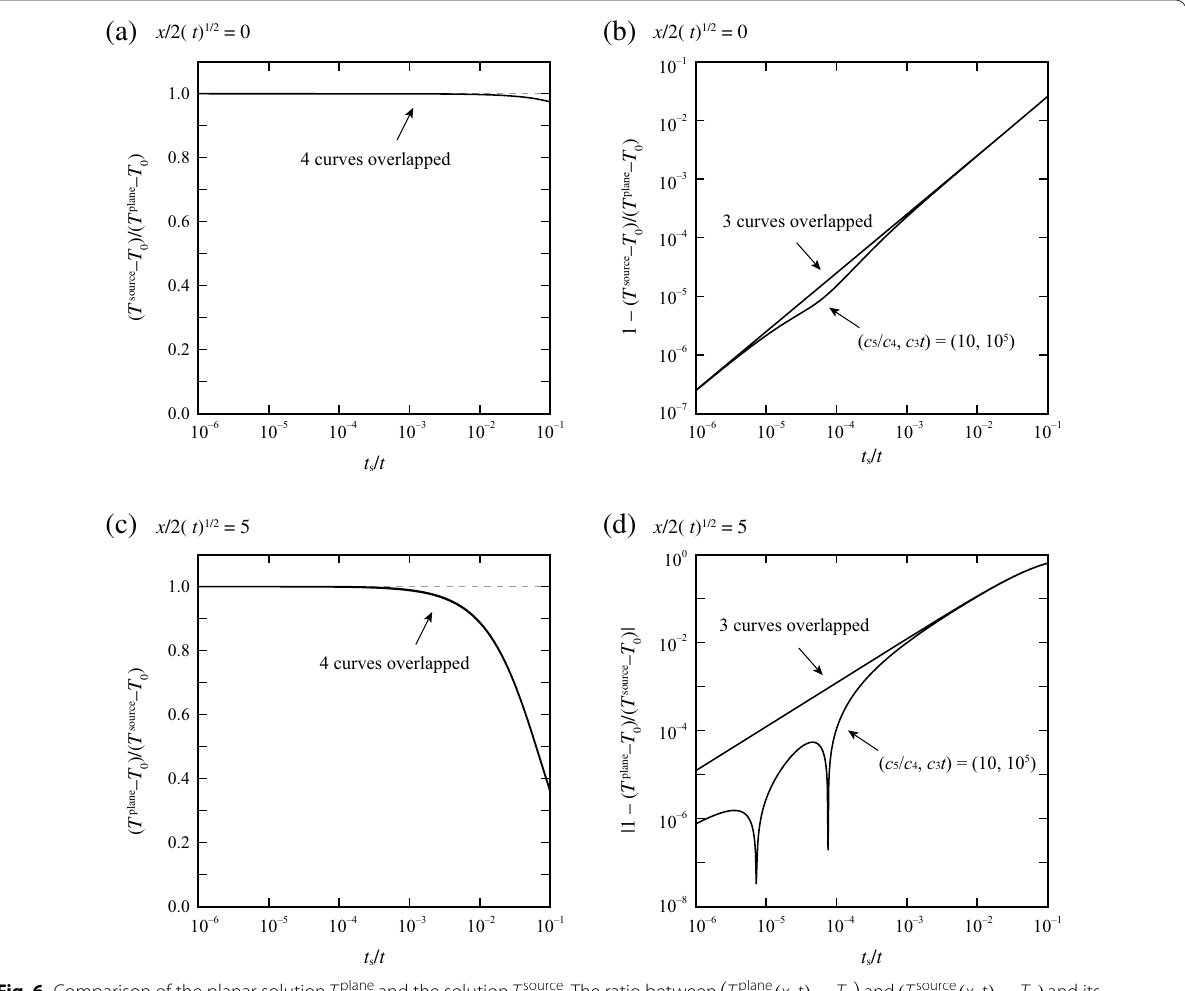
Fig. 6 Comparison of the planar solution T plane and the solution T source . The ratio between deviation from unity are plotted against the nondimensional parameter t s / t when a , b x / 2 √ α t solutions were calculated with Eqs. (23) and (29). The other nondimensional parameters were set to c 3 t